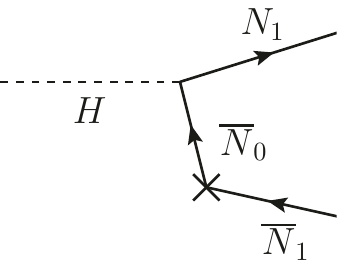
Figure 12 . Dominant interactions contributing to the decay of the electroweak doublets L . Anal- ogous interactions exist for E 0 + and N 0 . The cross is a Higgs vev insertion.